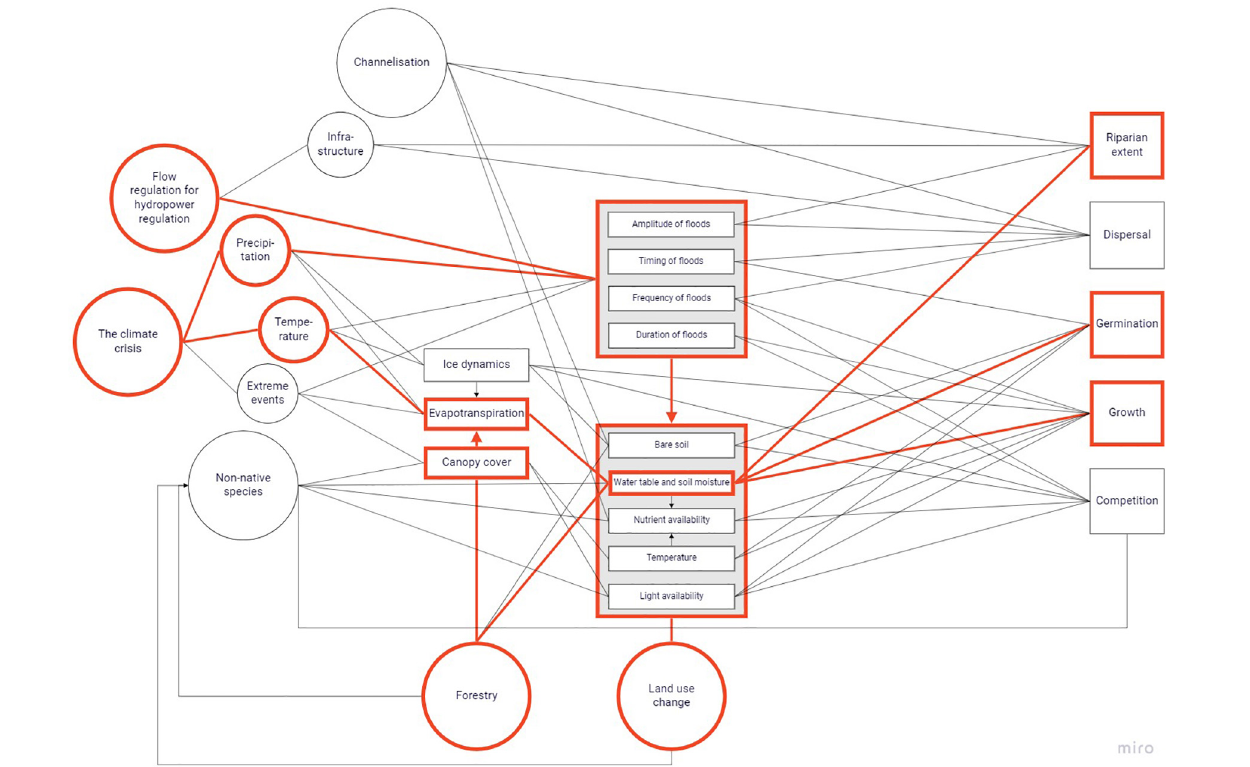
FIGURE 8 | An example of application of the conceptual model on the riparian soil water table. Pressures and processes that affect or are affected by the soil water table are marked in red. The soil water table then codetermines the extent to which plants successfully germinate and grow, in a riparian zone of which it also codetermines the extent ( Figure 8 ). Not all species or species groups react to these changes in a similar manner, and in this example riparian or flooding-tolerant species that are drought-sensitive or demand shading, may experience reduced germination success and growth, and may eventually be outcompeted by ruderal or shading-intolerant species.